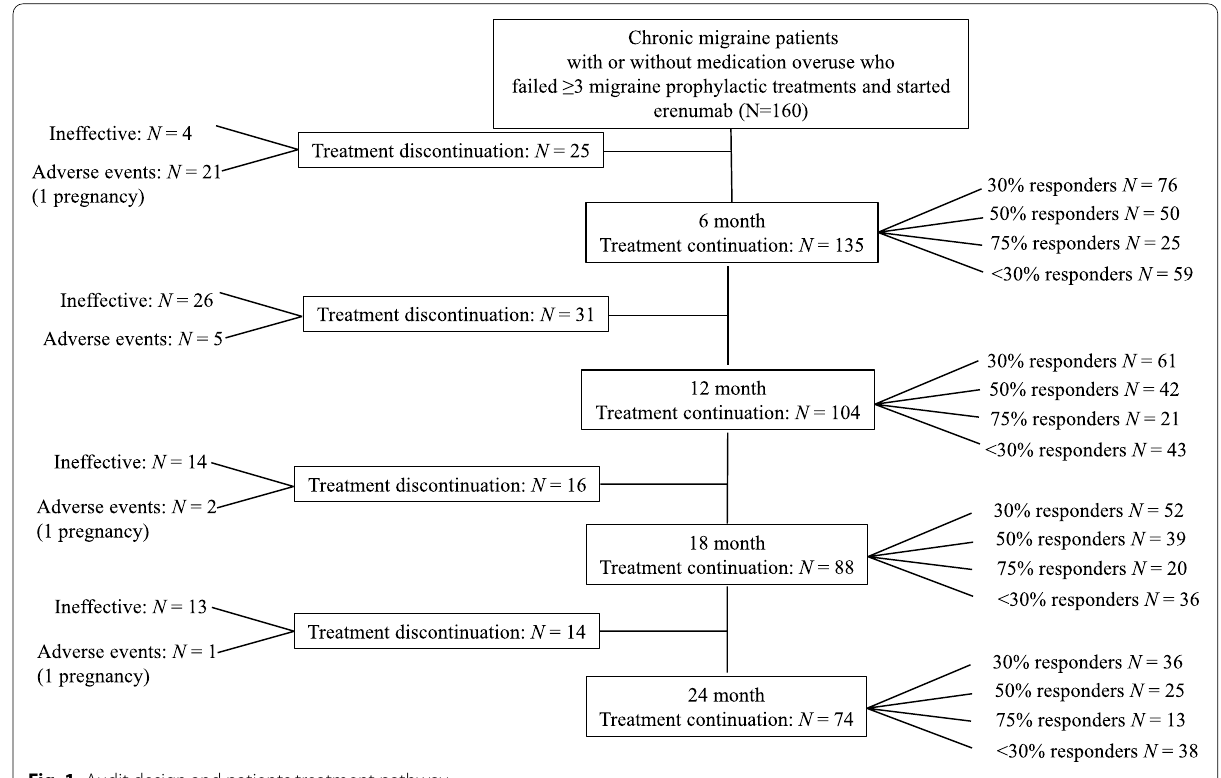
Fig. 1 Audit design and patients treatment